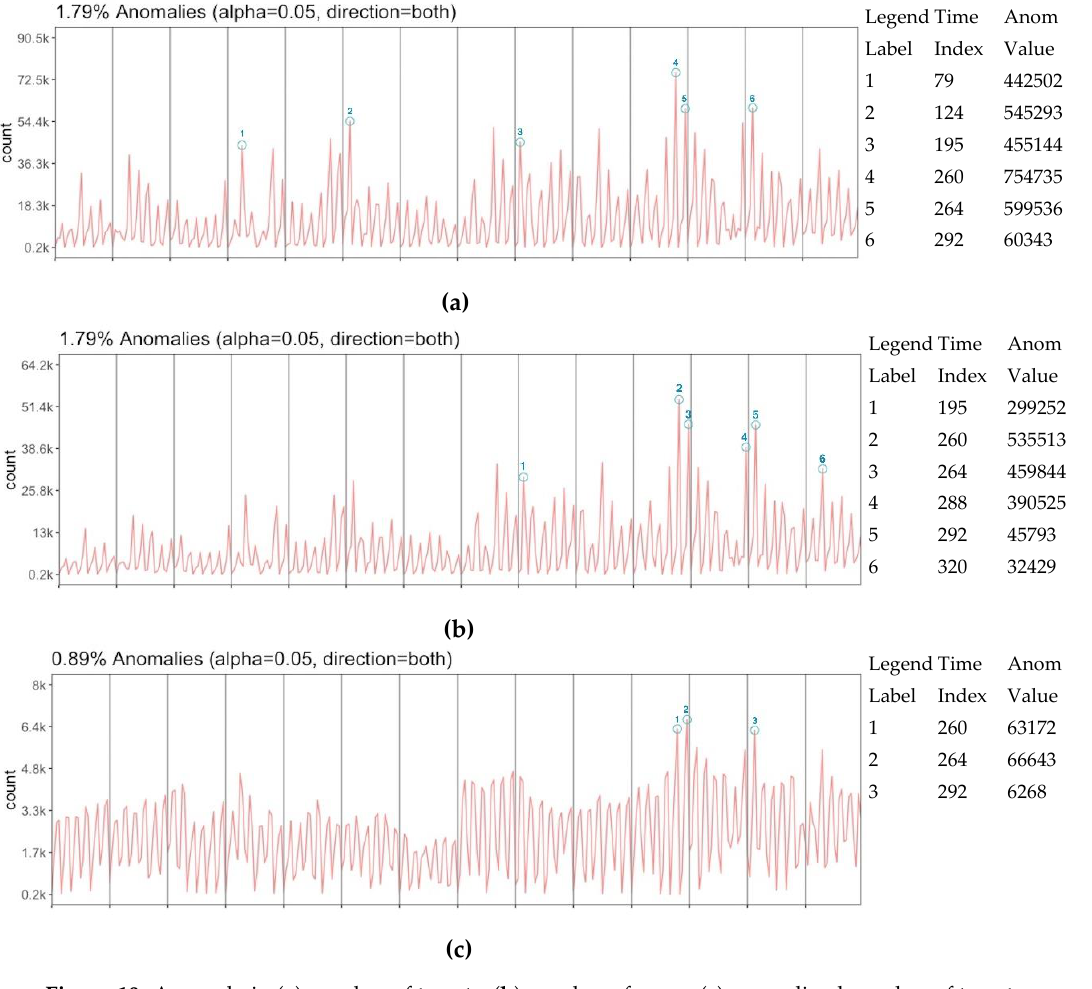
(a) (b) Figure 11. Istanbul city (a) figure and ground map for tweet representations; (b) urban area and social media geotags.